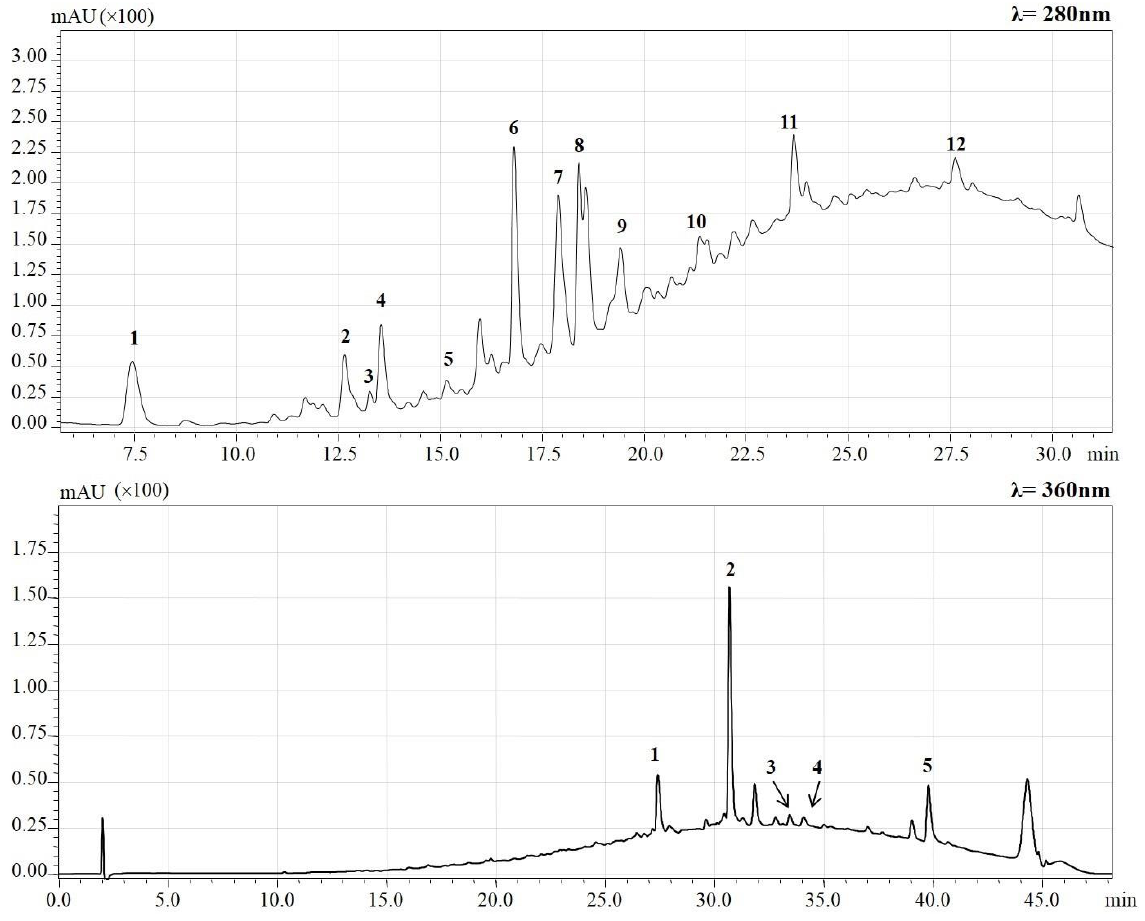
Figure 1. HPLC-PDA chromatograms of hazelnut skin phenolic compound profile, measured at λ = 280 nm and λ = 360 nm. Peak numbers refer phenolic compounds reported in detail in Table 1. For procyanidin beta type dimer gallate, procyanidin C2 trimer, prodelphinidin B dimer and procyanidin dimers, molecular standards were not available and only mass-to-charge ratio ( m / z ) of the molecular ion was considered. (+)-Catechin, and ( − )-epicatechin, having the same mass-to charge ratio ( m / z ), were identified using purified ( − ) epicatechin as standard molecules and comparing the retention times. All the detected phenolic compounds were previously identified in hazelnut skin [33,37]. Calibration curves with external standard were constructed for each available standard molecule and linearity concentration range was between 1 and 100 mg/L for each curve. Phenolic compounds were quantified using the calibration curve of their standard molecule, if available, while procyanidins and prodelphinidins were quantified using the calibration curve of procyanidin B2 dimer, and (+) catechin using the calibration curve of ( − ) epicatechin. A total phenolic compound concentration of 445 mg/100 g was determined. As previously reported by Del Rio et al. [37], flavan-3-ols represent the main class of phenolic compounds in hazelnut skin. Procyanidin dimers resulted in being the two compounds present in high quantity with a concentration of 100 and 93 mg/100 g, respectively, followed by (+) catechin with a concentration of 62 mg/100 g. Among detected flavonols, quercetin-3-rhamnoside showed the highest quantity, with a concentration of 40 mg/100 g, confirming data reported in the literature [37]. The concentration of each identified phenolic compounds is reported in Table